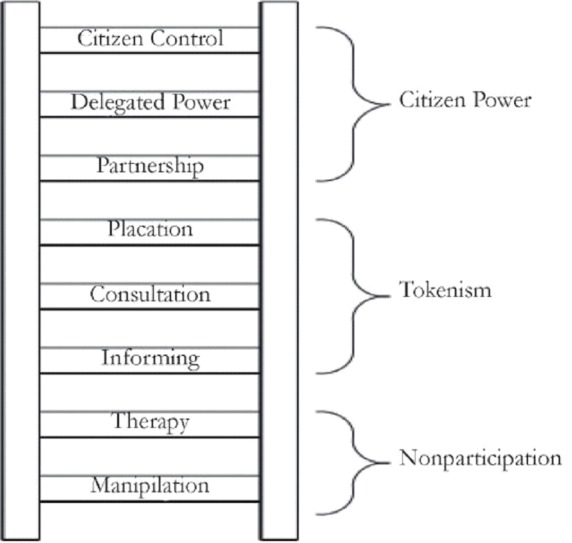
Ladder of citizen participation [13].